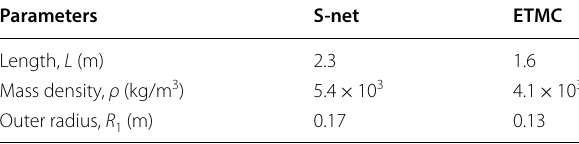
Table 3 Pressure vessel parameters for S‑net and ETMC Parameters S‑net Length, L (m)